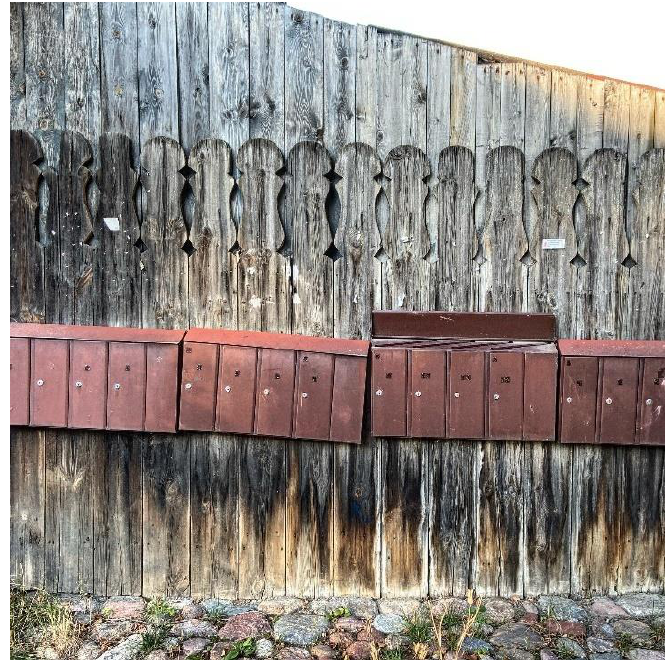
Figure 9. Metal mailboxes in Šnipiškės. Photo by A. Gabrėnas .